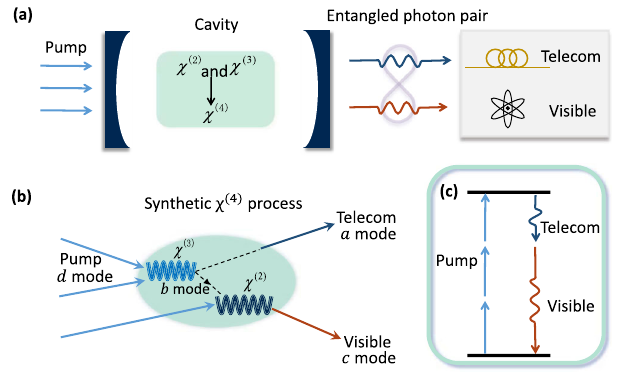
Fig. 1 | Schematic illustration of synthetic fi ve-wave mixing. a Synthetic χ (4) processconstructedbycavity-enhanced χ (2) and χ (3) nonlinearprocessesforvisible- telecom entangled photon-pair generation. b , c The scattering map and the equivalent energy level diagram of the synthetic χ (4)